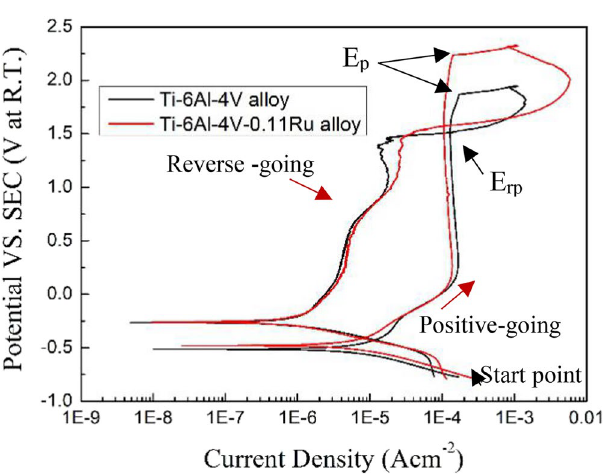
Figure 3. Cyclic polarization curves of different titanium alloys under test Condition